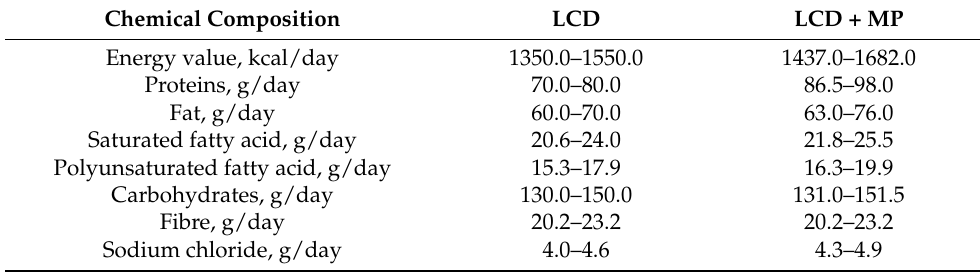
Figure 1. CONSORT flow diagram of participants’ progress through each stage of the study. Participants in the control group (n = 18) consumed a standard hyposodium low-calorie diet (LCD) for 28–30 days (7–10 days as an inpatient and 18–20 days as an outpatient), while subjects in the experimental group (n = 18) received the LCD and 100 g MP per day. The LCD is a diet with a significant restriction of fat and easily digestible carbohydrates that contains a normal level of protein and complex carbohydrates, with an increased amount of dietary fibre and a reduction in the amount of table salt (3–5 g/day). The chemical composition of the LCD and the modified diet with the MP is pre- sented in Table 1. Table 1. Chemical composition of control and experimental diets during the